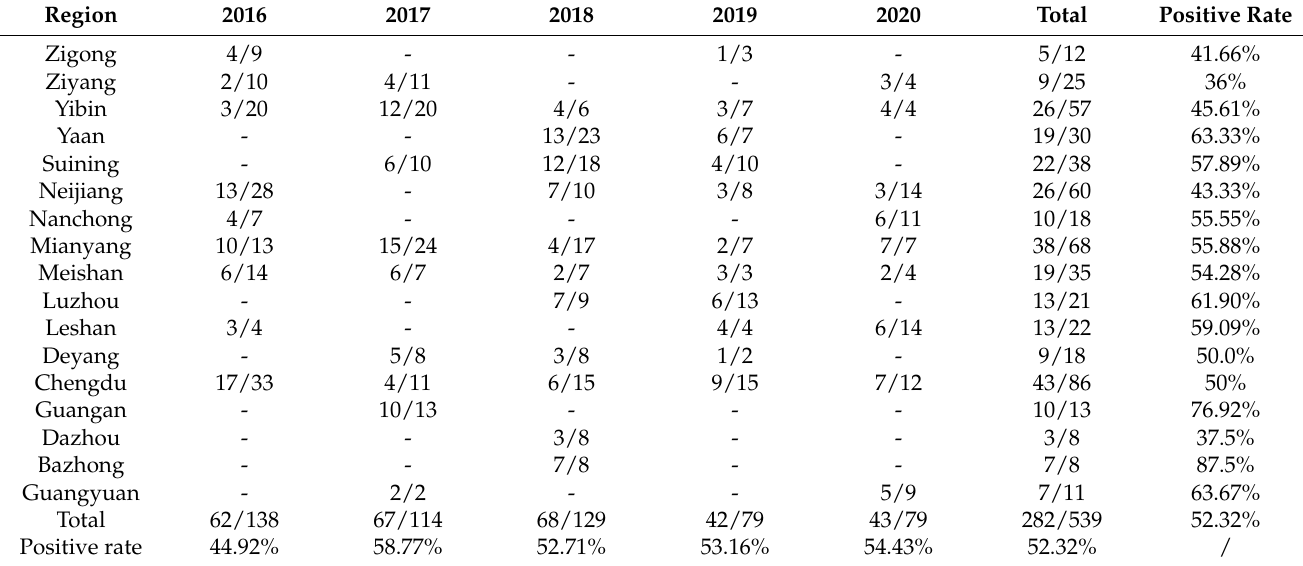
Table 1. Statistics data of PRRSV positive